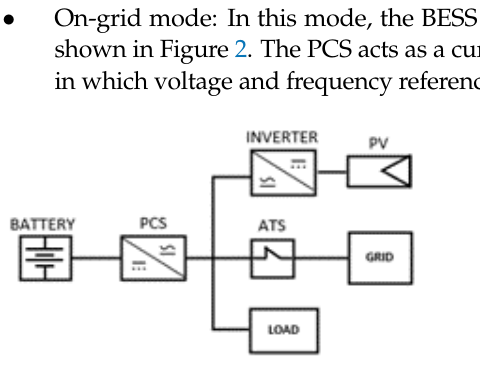
Figure 2. Grid-Connected Mode.